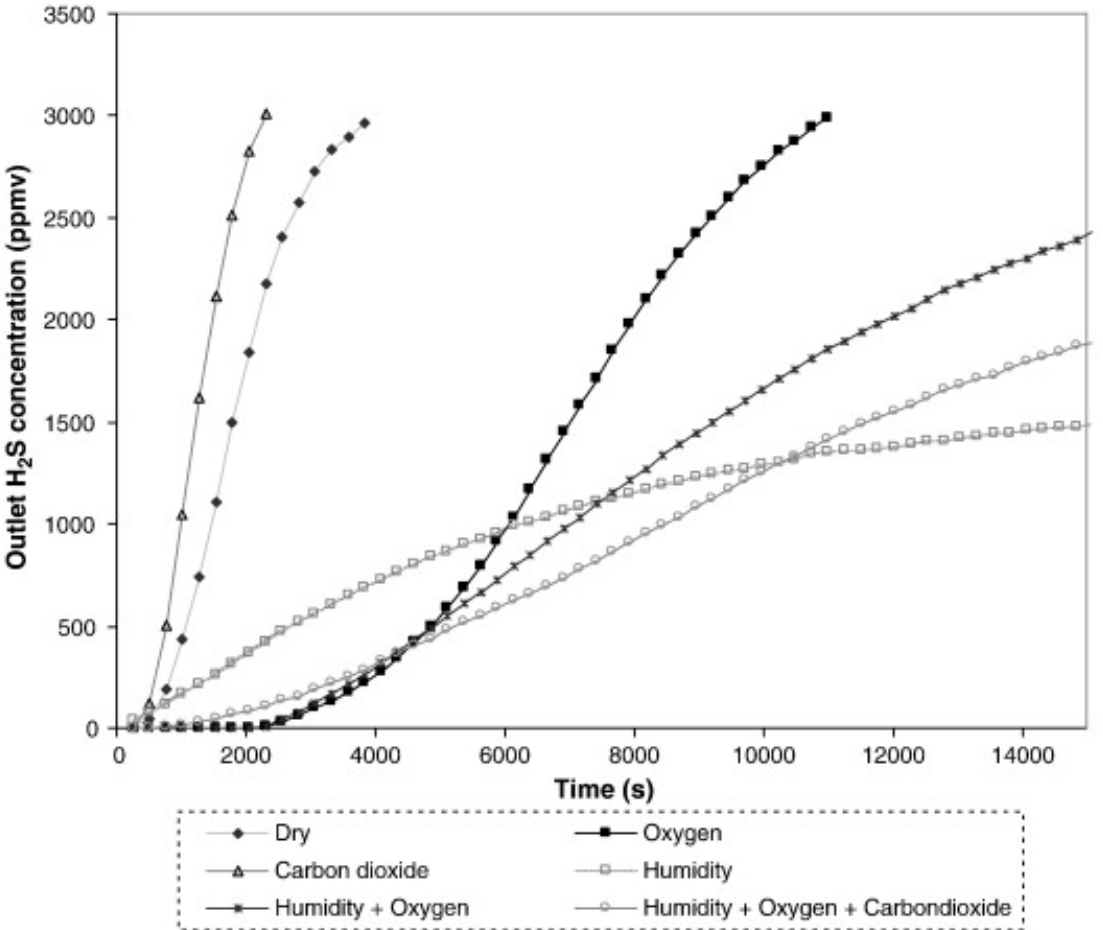
Figure 4. Adsorption curves of a fixed bed reactor for H 2 S removal from different stream composi- tions. Reprinted with permission from [42]; published by Elsevier, 2014.